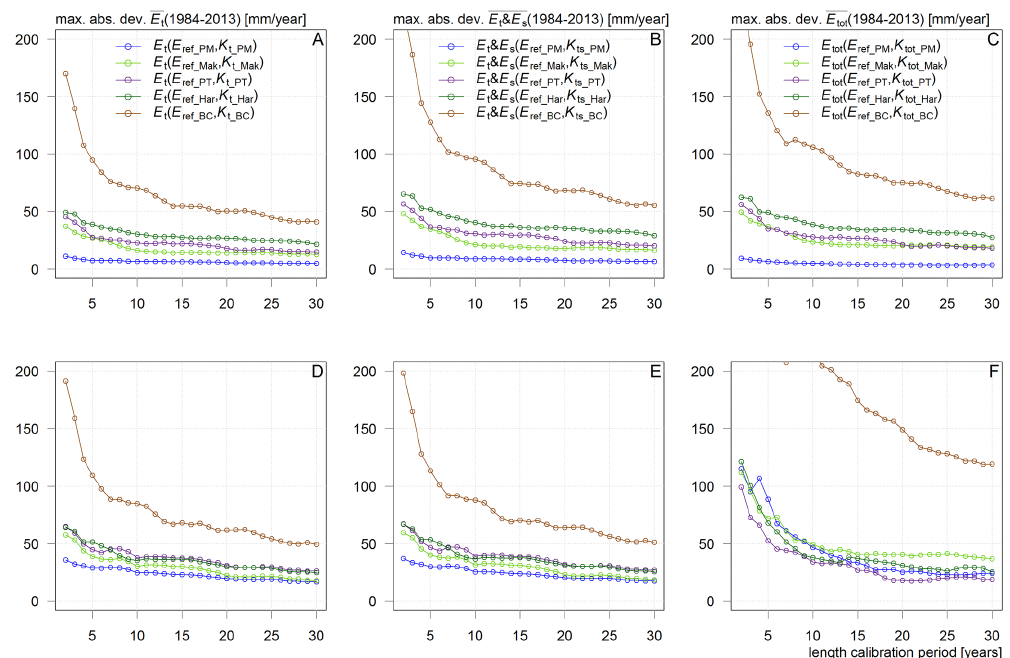
Figure 9. Maximum absolute deviation with synthetic “observations” in mean E t (a, d) , E t & E s (b, e) , and E tot (c, f) for the period 1984– 2013, for heather (a–c) and spruce (d–f) , obtained by the two-step approach, as a function of the length of the calibration period. Presented as in Fig. 5, though using E ref and crop factors ( K t , K ts and K tot ) to derive E t , E t & E s , and E tot